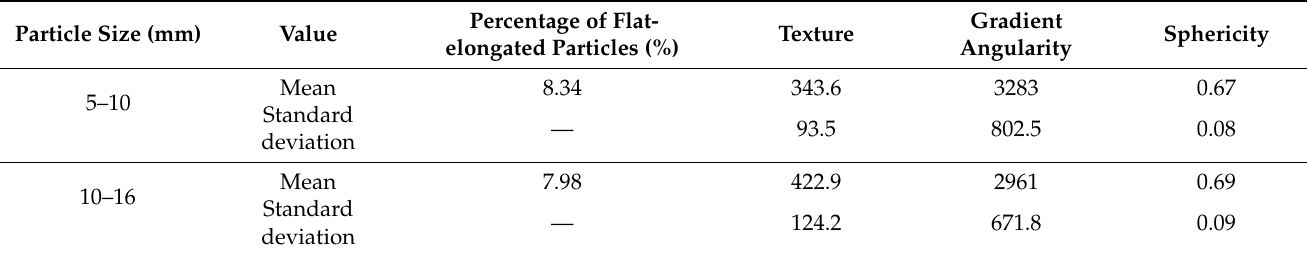
Table 3. Morphology measurement of basalt